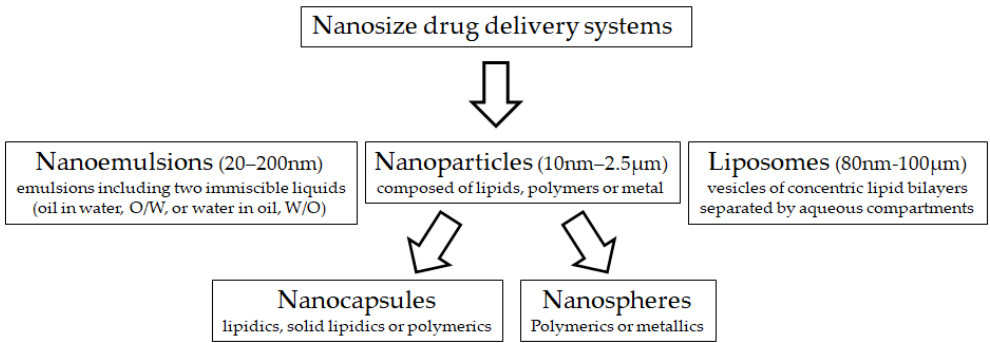
Figure 1. Main nano-sized material used for drug delivery systems.